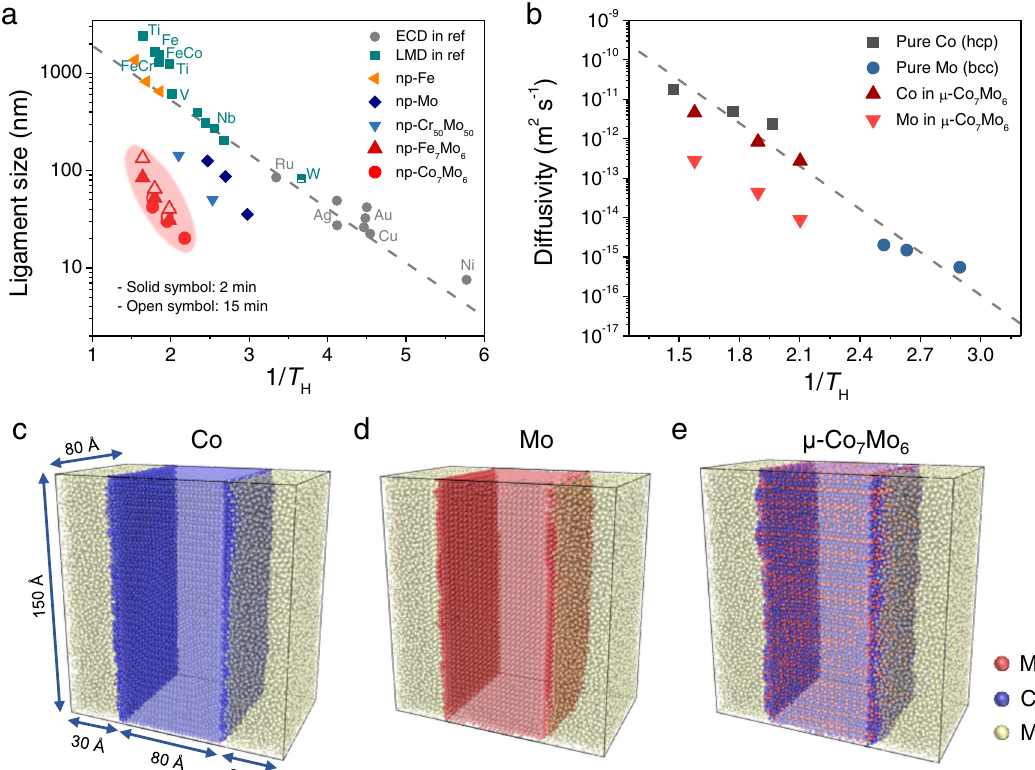
Fig. 3 | Characteristic lengths of the nanoporous intermetallic compounds (or alloys) and molecular dynamics simulations of the interfacial diffusivities. a Ligament size versus the inverse homologous temperature, 1/ T H (i.e., T m / T dealloy ), for the nanoporous intermetallic compounds (or alloys) and the ele- mental metals. Data for other porous metals fabricated by LMD (cyan squares) and ECD (gray circles) adapted from a reference 56 are included for comparison. Dealloying time is 10min for LMD data from references, except for W, which is 20min. For data from the present study, the dealloying time is 2min for the